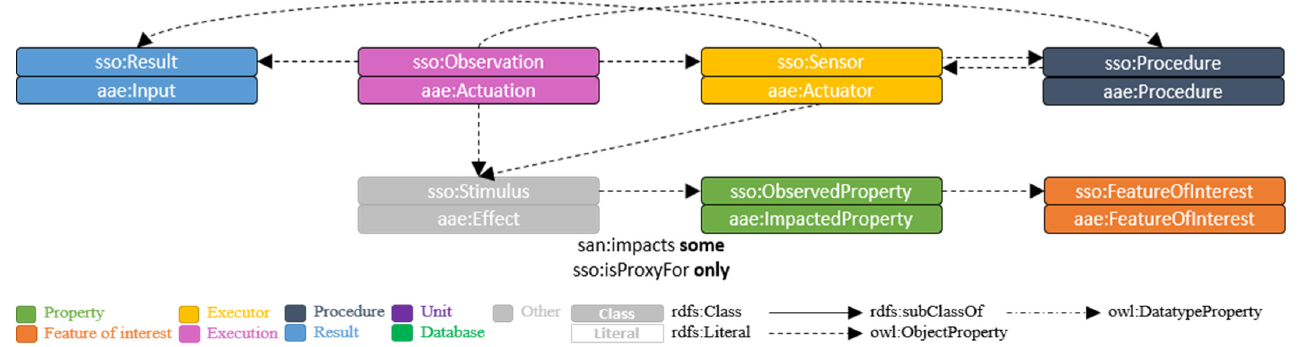
Figure 6. SSO ( top ) and AAE ( bottom ) using similar design patterns.